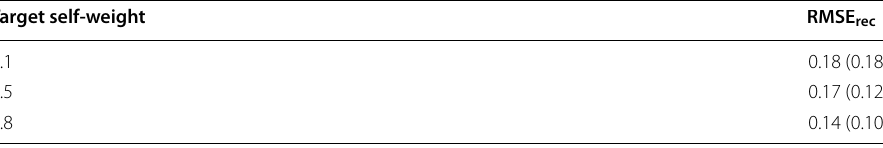
Median and IQR of RMSE for model parameter recovery by target self‑weight